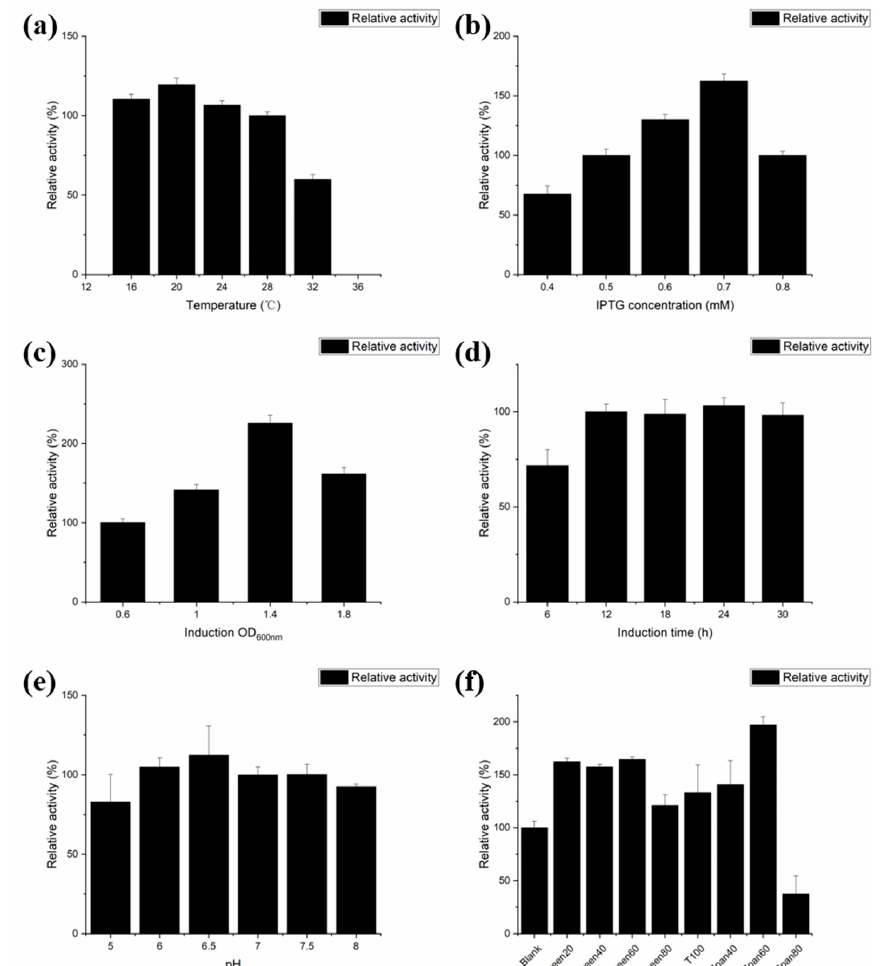
Figure 4. Optimization of the fermentation conditions for the secretory expression of PLD PMF . ( a ) The e ff ect of induction temperature. ( b ) The e ff ect of the concentration of β -d-1-thiogalactopyranoside (IPTG). ( c ) The e ff ect of the induction OD 600nm . ( d ) The e ff ect of the induction time. ( e ) The e ff ect of